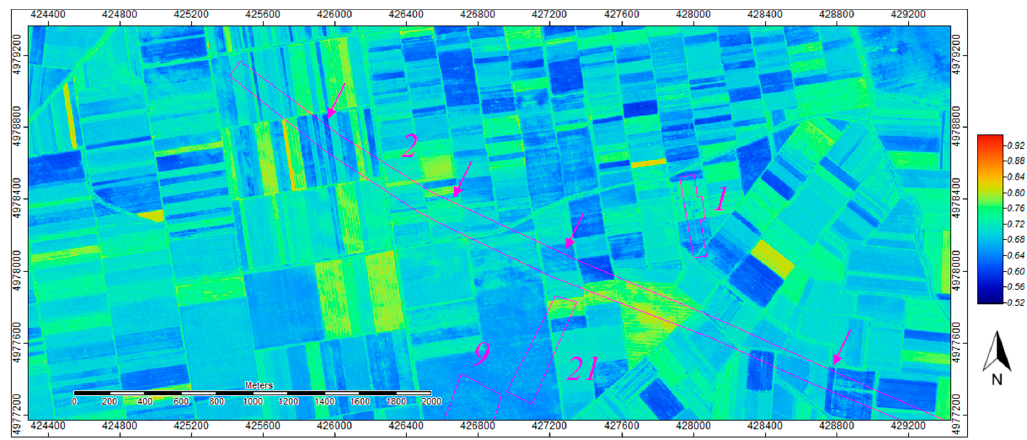
Figure 7. Output details for CC3 algorithm application to the WorldView2 image. The crop-marks identifying the presence of the Roman road and of other buried archaeological remains are marked in magenta. Data provided by the European Space Agency. The arrows mark the visible traces of the road. For a geographical reference, see the crop-marks identification numbers and locations in Figure 9.